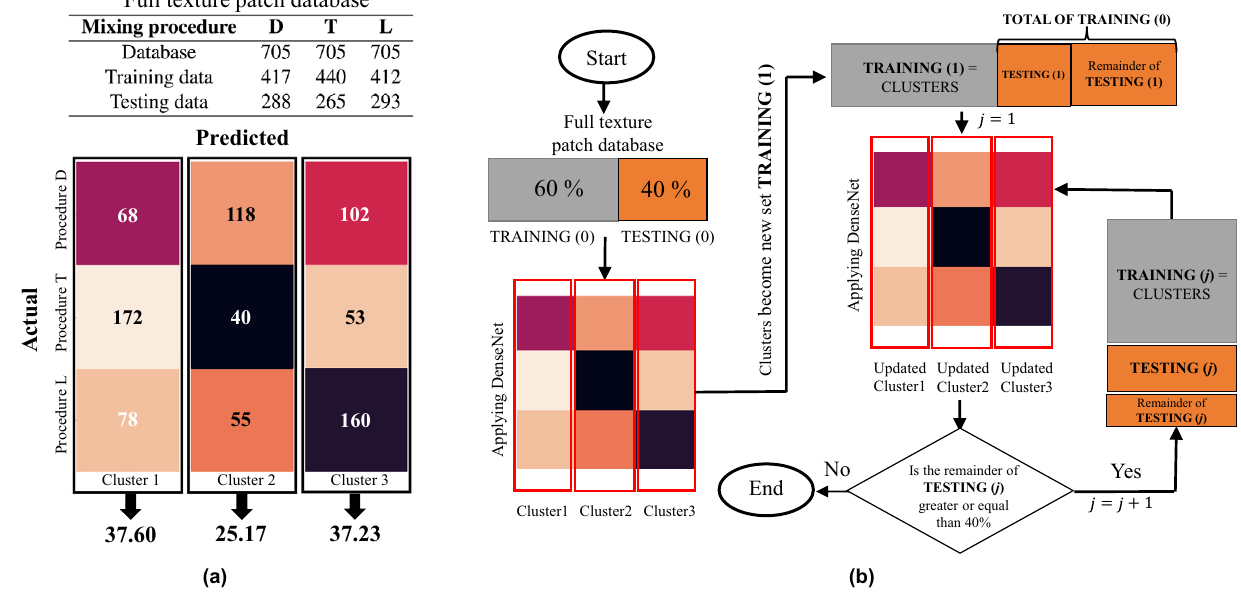
Figure 3. The proposed patch clustering method. ( a ) First clustering using DenseNet121. In the confusion matrix, Actual corresponds to the mixing procedures and Predicted to the clusters. ( b ) Flowchart of the iterative cluster aggregation process applied the whole patch database.